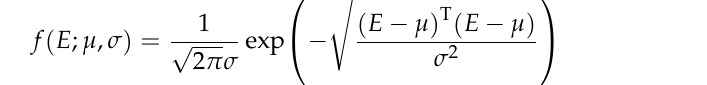
Figure 3. Two of the most frequently used initialization methods. ( a ) The initialization of SLIC [20] and its variant algorithms; ( b ) The initialization of SEEDS